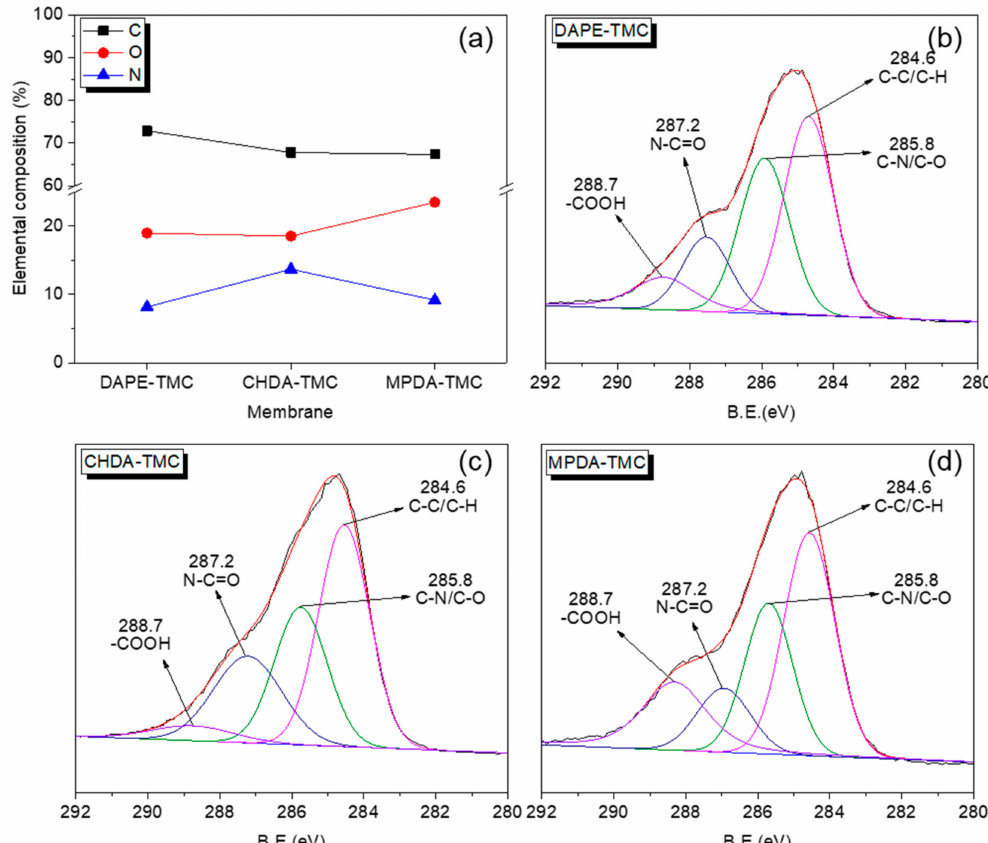
Figure 4. ( a ) Elemental compositions and ( b – d ) C1s spectra of TFC membranes.